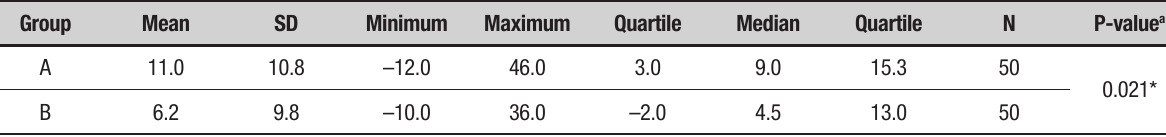
Table 3. ANU-ADRI score range.